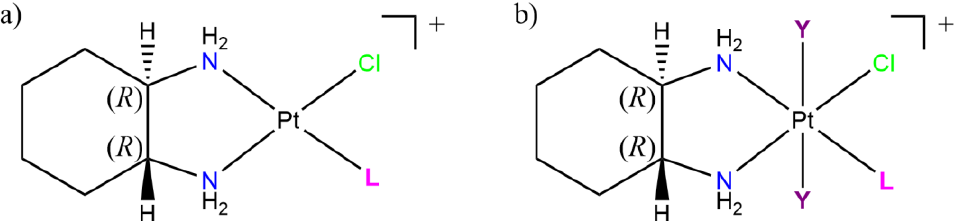
Figure 10. Chemical structures of model platinum(II) and (IV) nucleoside monoadducts of the type ( a ) [Pt(DACH)LCl]NO 3 and ( b ) [Pt(DACH){ trans -(Y) 2 }LCl]NO 3 , respectively. DACH = trans - 1R , 2R - diaminocyclohexane; L = adenine, guanine, hypoxanthine, cytosine, adenosine, guanosine, inosine, cytidine, 9-ethylguanine, or 1-methylcytosine; Y = OH, acetate.